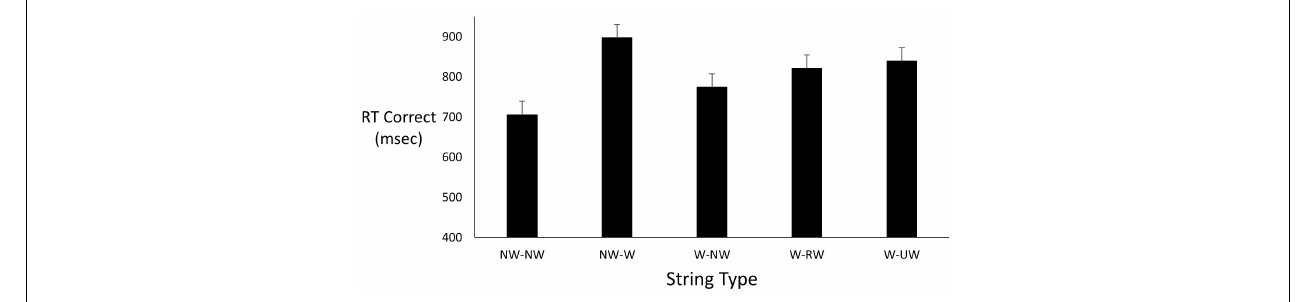
FIGURE 2 | Mean correct RT as a function of string type. String types abbreviated here are identified in the top panel of Figure 1 .